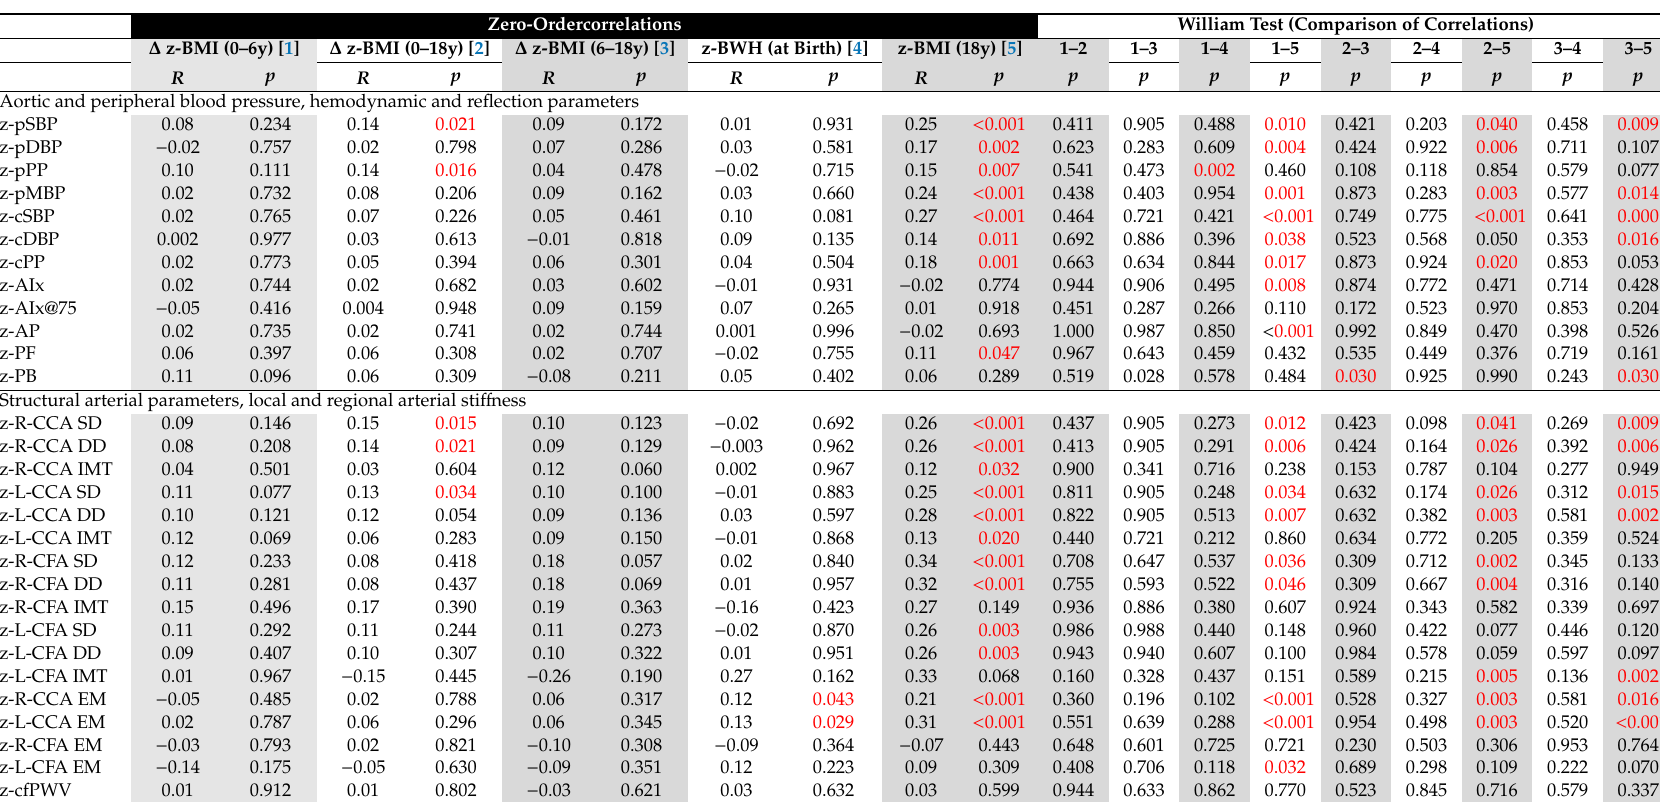
Table 3. Comparative analysis CV variables’ association with anthropometric characteristics at birth, at 18 y and with anthropometric changes within that period (0–6, 0–18, 6–18 y) [adolescent cohort, n =